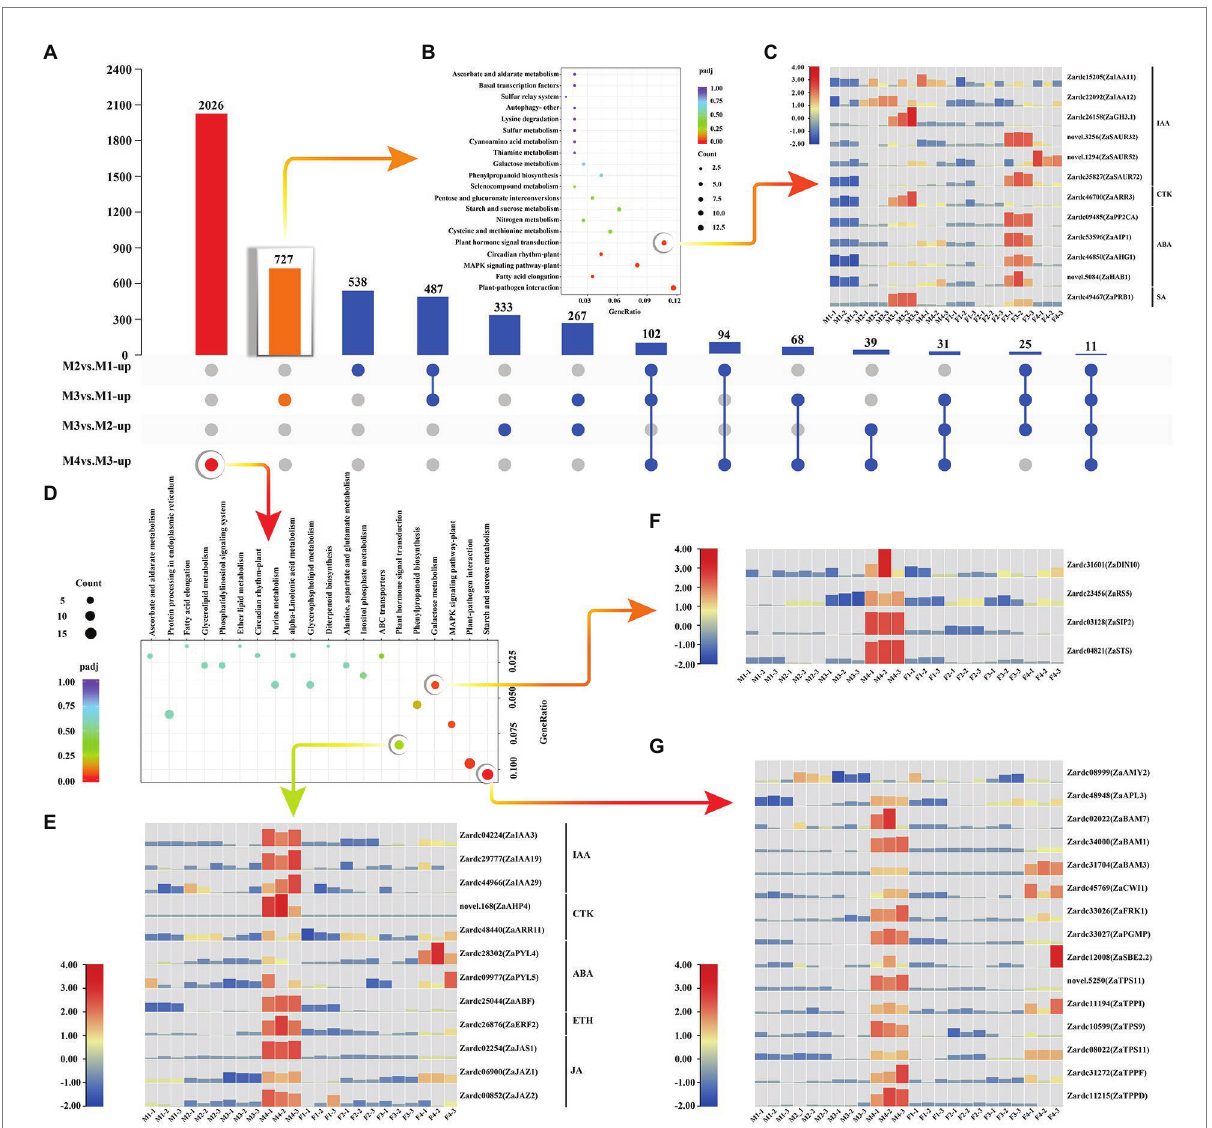
FIGURE 2 The key genes selection involved in male floral differentiation. (A) The upset statistics of up-regulated DEGs among male floral samples. (B) The KEGG enrichment of the up-regulated DEGs in M3 vs. M1. (C) The heat map of the DEGs associated with plant hormone signal transduction which was the significant enrichment pathway in M3 vs. M1. (D) The KEGG enrichment of the up-regulated DEGs in M4 vs. M3. (E) The heat map of the enriched DEGs related to plant hormone signal transduction in M4 vs. M3. (F) The heat map of the DEGs involved in galactose metabolism which was the significant enrichment pathway in M4 vs. M3. (G) The heat map of the enriched DEGs associated with starch and sucrose metabolism in M4 vs.